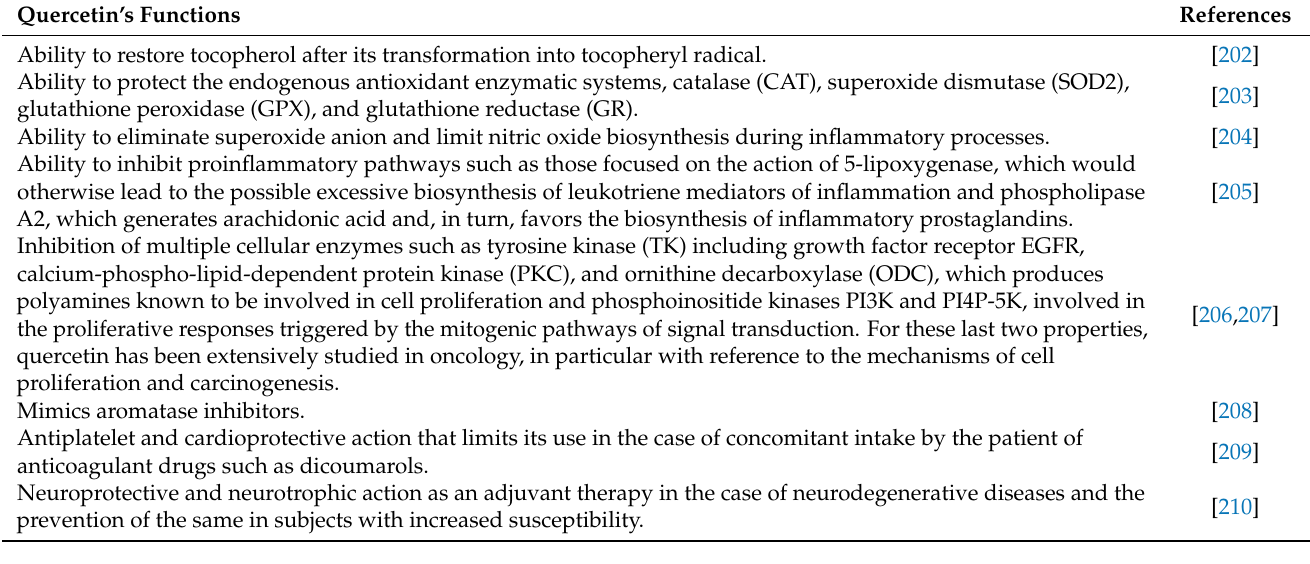
Table 3. The most important functions of